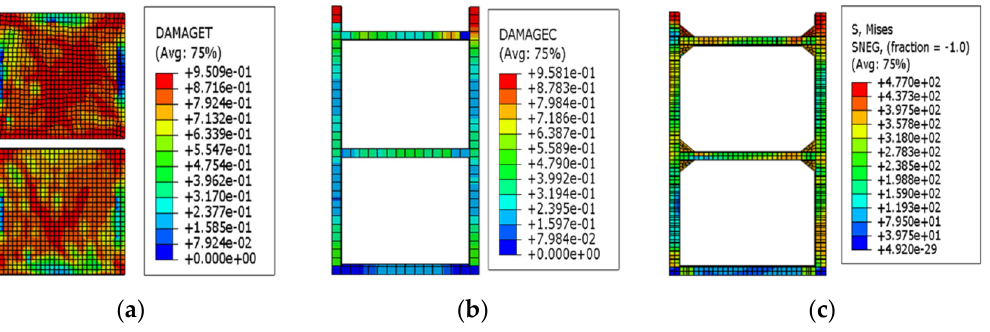
Figure 9. Stress contour plots at a drift ratio of 1/27. ( a ) Stress contour plot of the wall concrete; ( b ) stress contour plot of the concrete cast in the steel tubular columns; and ( c ) von Mises stress contour plot of the boundary steel tubular columns.